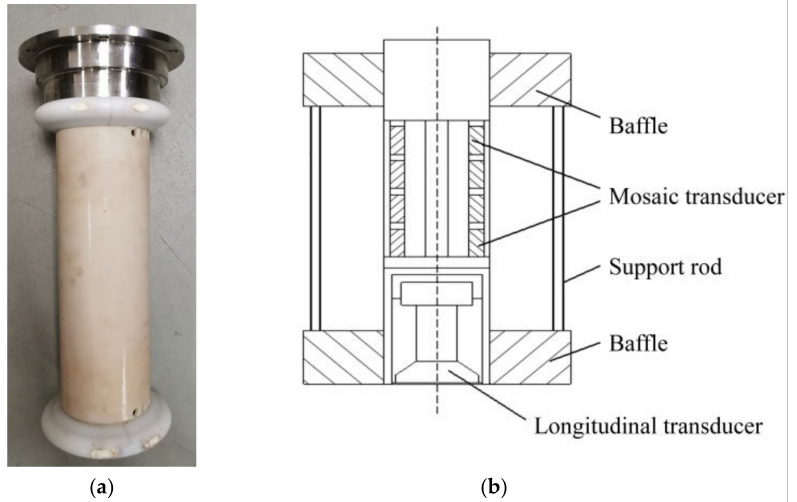
Figure 5. The shipborne transducer array of the Shenhai Yongshi HOV. ( a ) picture of array, ( b ) struc- ture picture.